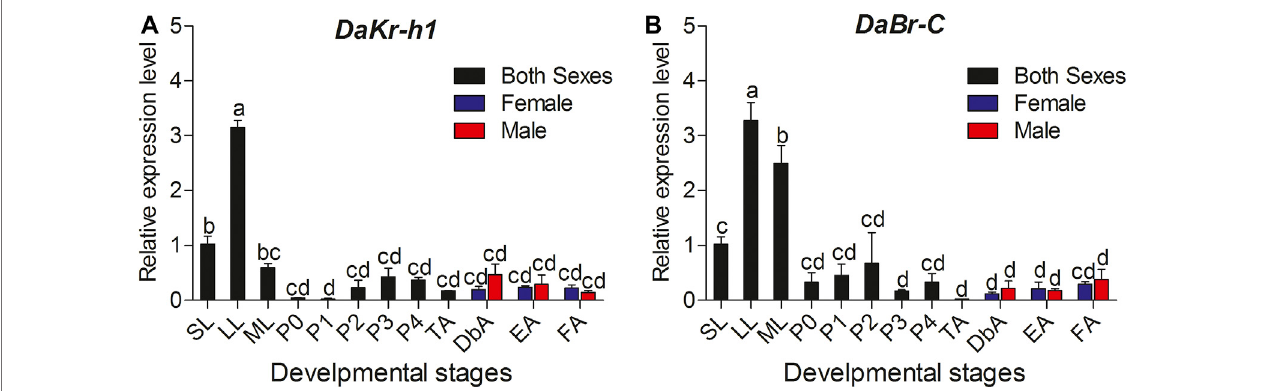
FIGURE 2 | Quantitative expressions of DaKr-h1 and DaBr-C genes at different stages of D. armandi . (A) DaKr-h1 ; (B) DaBr-C . Small larvae (SL: penultimate (or pre- fi nal) instar larva weighing less than 2.5 mg);largelarvae (LL: fi nal instar, feedinglarva weighing5.0 – 7.0 mg); mature larva (ML: post-feeding fi nalinstarlarva). Pupae wereseparatedinto fi vesub-stages:P0:pupae,P1:Day1ofthepupalstage,P2:Day2ofthepupalstage,P3:Day3ofthepupalstageandP4:Day4ofthepupalstage. D. armandi adults were separated into four sub-stages: teneral adults (TA: body color still light), dark brown adults (DbA: Adults darkened to dark brown, but were still under the bark and had not migrated), emergent adults (EA), and feeding adults (invading a new host) of D. armandi . Data are means ± SE of three independent experiments. All templates were normalized with CYP 4G55 and β -actin . The 2 − ΔΔ Ct and SE values were used for plotting the graph. Different letters indicate signi fi cant differences at p < 0.05 (one-way ANOVA, with Tukey ’ s test of multiple